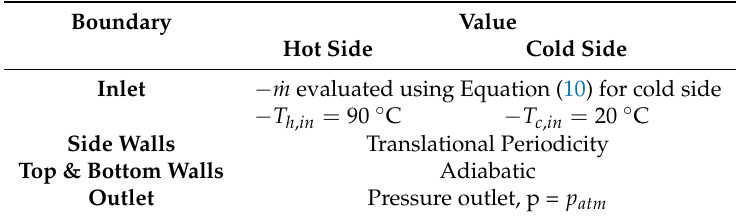
Table 2. Boundary conditions used in the CHT